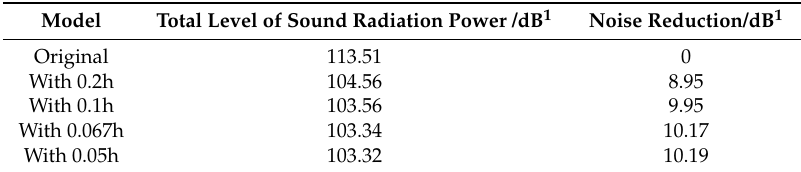
Figure 19. The curves of sound radiation power from the models with leading-edge serrations of different wavelengths, when the amplitude of the leading-edge serrations is 0.025c. ( a ) The narrow band; ( b ) The one-third octave band. Table 4. The total level of sound radiation power from the model with leading-edge serrations of different wavelengths at an amplitude of 0.025c.